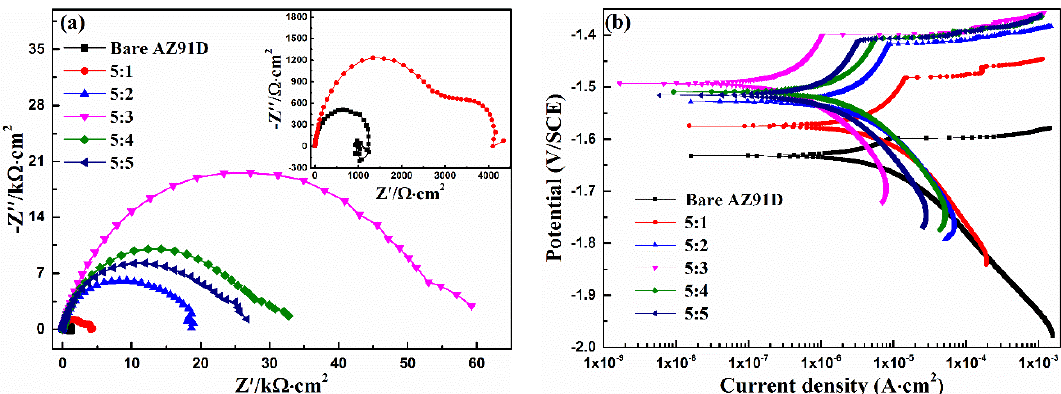
Figure 1. The electrochemical impedance spectroscopy (EIS) plots ( a ) and potentiodynamic polarization curves ( b ) of bare AZ91D alloy and the calcium phosphate coatings obtained from different concentration ratios of Ca-P solution in 3.5 wt % NaCl solution.